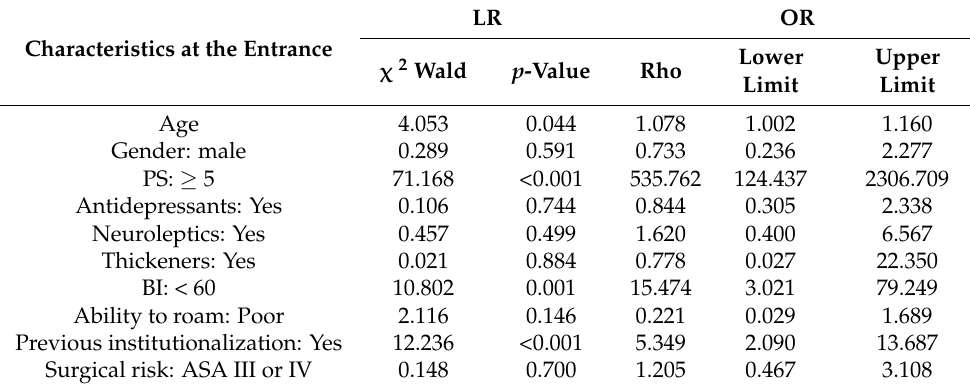
Table 2. Results of binary logistic regression to estimate the relationship between clinical characteris- tics at admission and cognitive impairment at the sixth